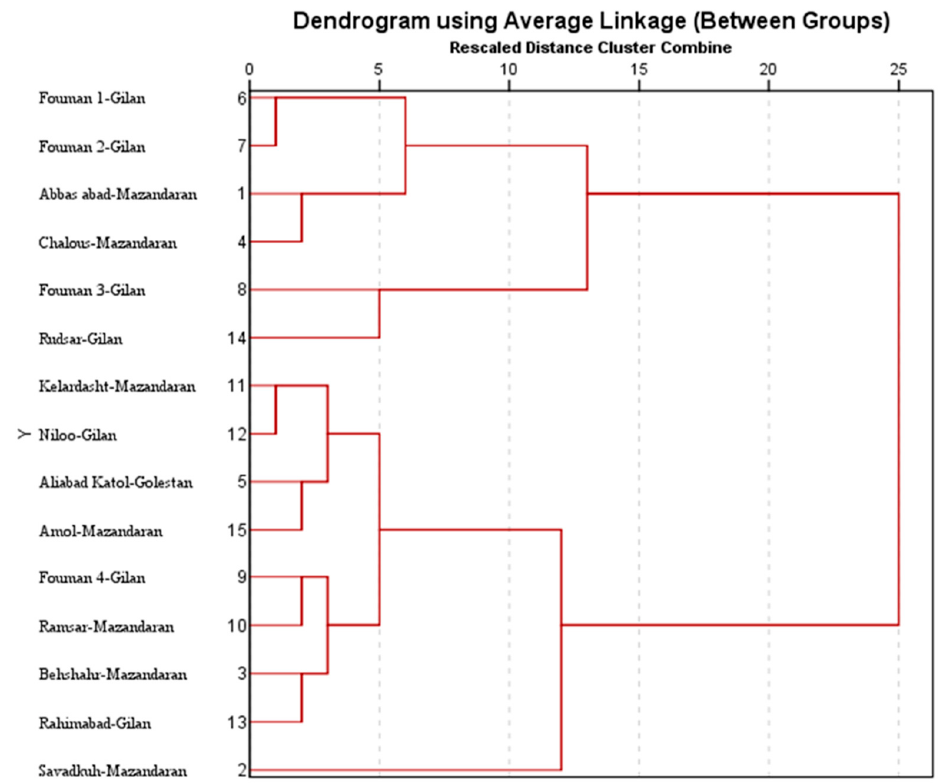
Figure 9. Dendrogram of cluster analysis for essential oil components of M. aquatica populations from the Hyrcanian hotspot of Iran.